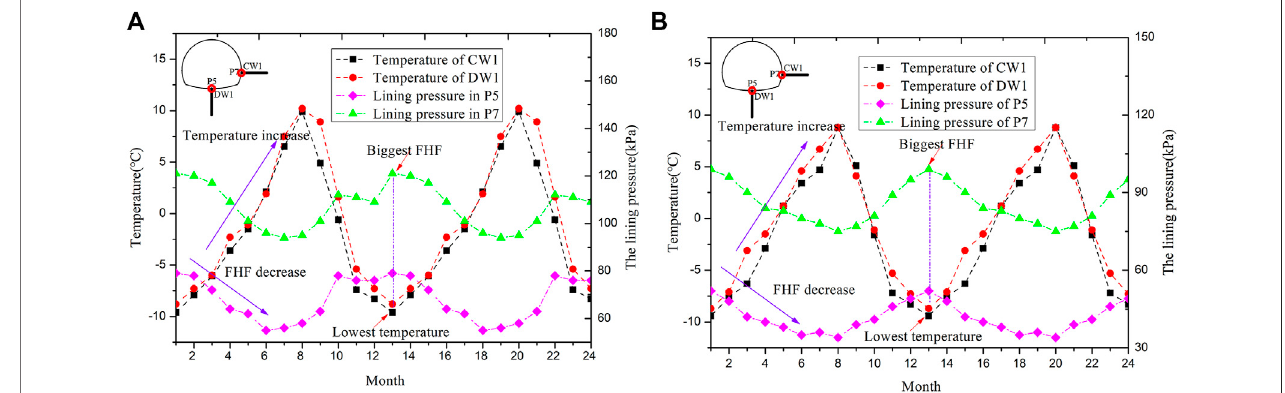
FIGURE 5 | The FHF change with temperature. (A) Section 700 (B) Section 600.